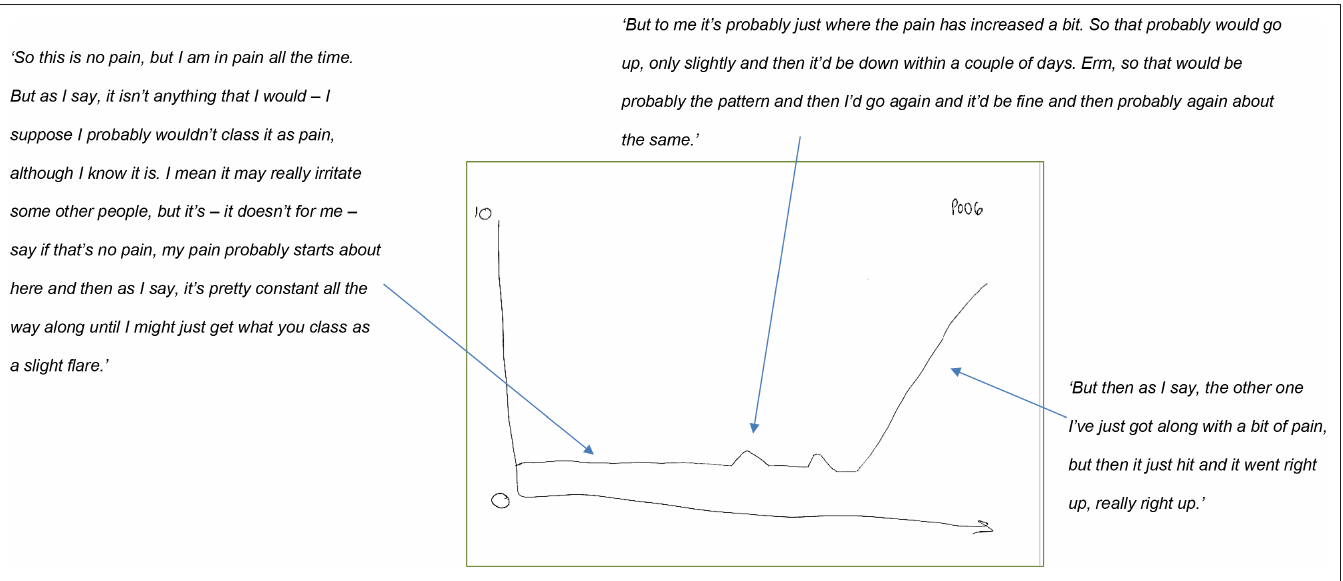
Figure 1 Illustration of pain variability over the previous 6 months on a 0–10 numerical scale with annotation (P06, F, aged 68